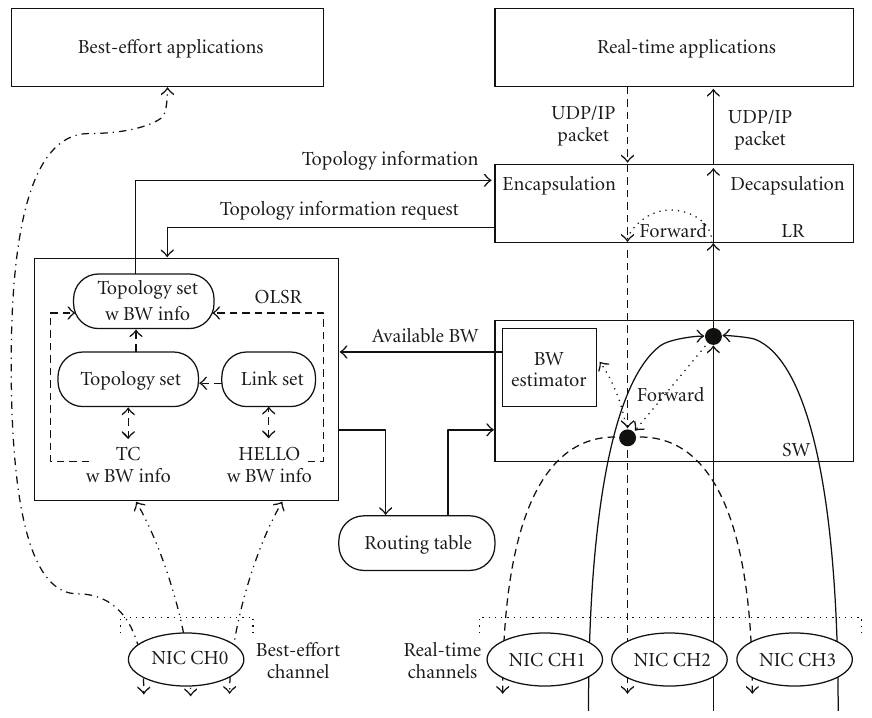
Figure 3: Module components of proposed mechanism (dashed: outgoing, plain: incoming, dot-dashed: control flow).